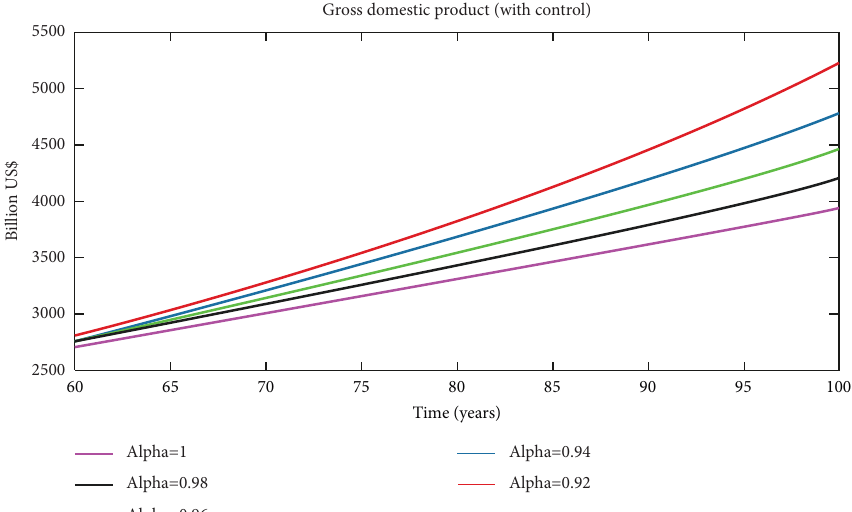
Figure 12: Comparison of GDP with control with diferent values of